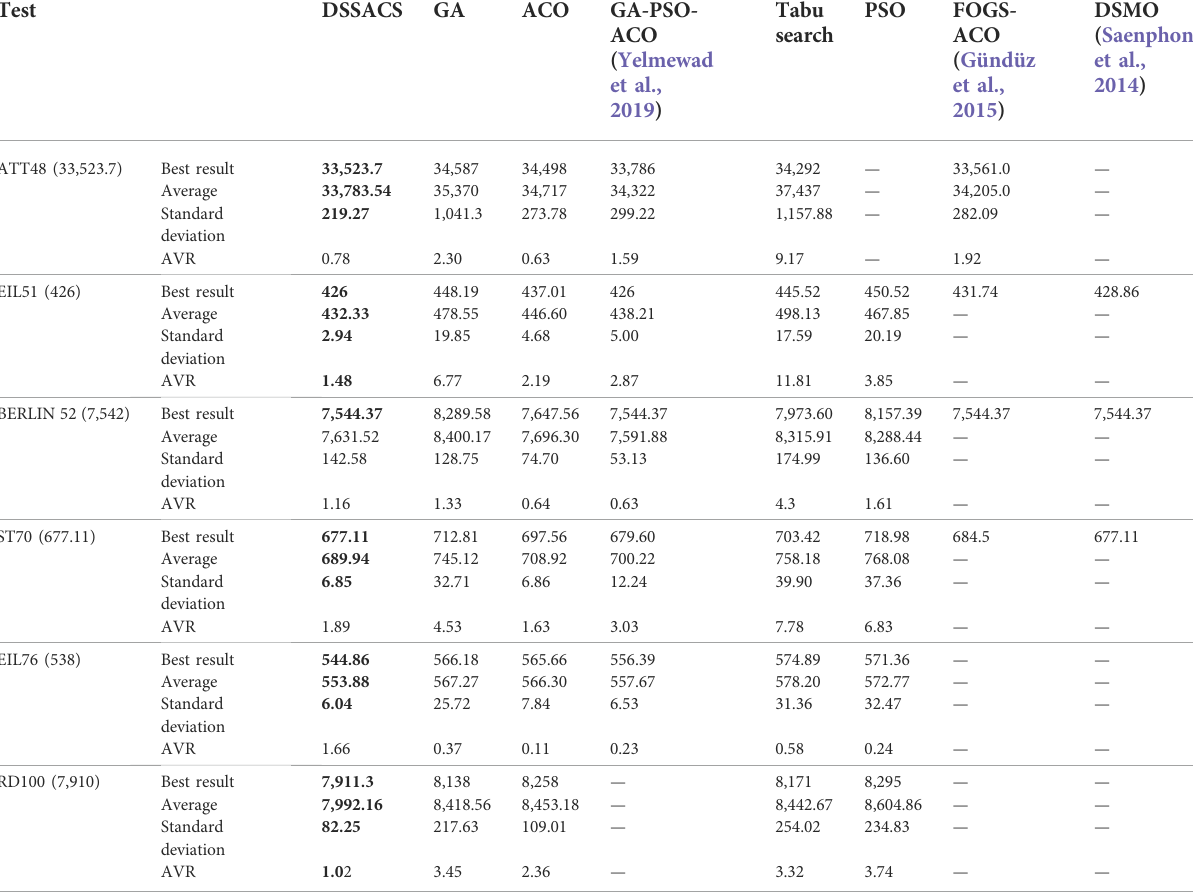
TABLE 2 The comparison results of algorithms. (If the result of DSSACS is better than other algorithms, it will be marked in bold). Test